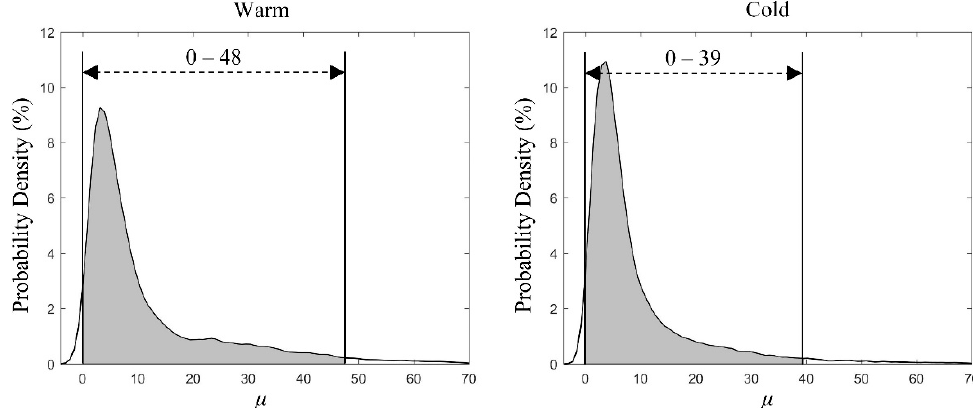
Figure 6. Shape parameter constraint intervals for different seasons derived from the disdrometer data throughout2013–2017.